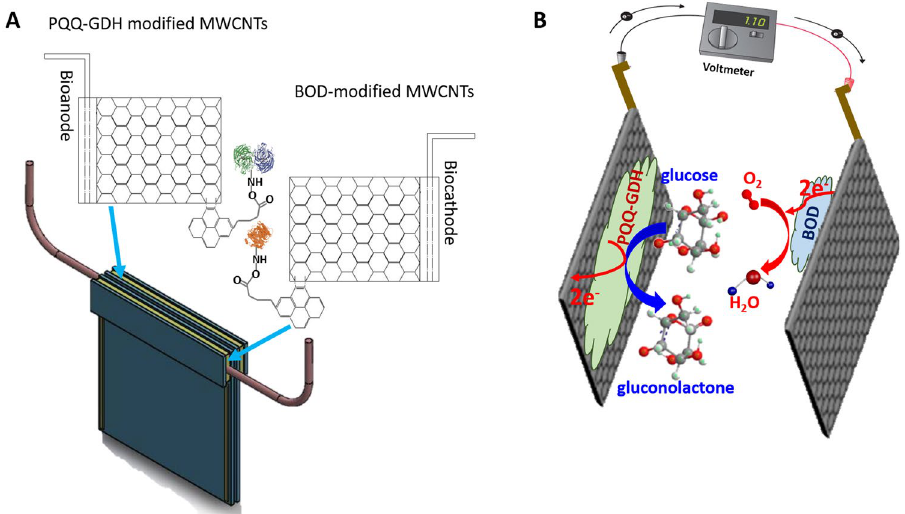
Figure 1. ( A ) Schematic illustration of the enzymatic glucose biofuel cell unit construction using dense mesh network of multi-walled carbon nanotubes (MWCNTs) modified with PQQ-GDH and BOD at the bioanode and biocathode, respectively; ( B ) 3D glucose biofuel cell unit and its function in the electrocatalytic oxidation of glucose and reduction of molecular